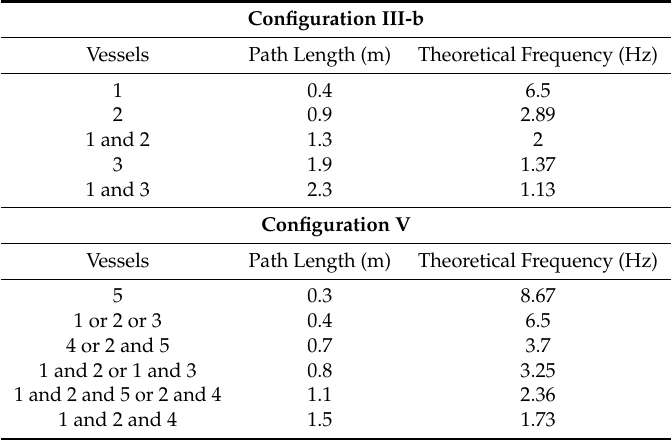
Table 2. A list of the possible paths and the theoretical natural frequencies.